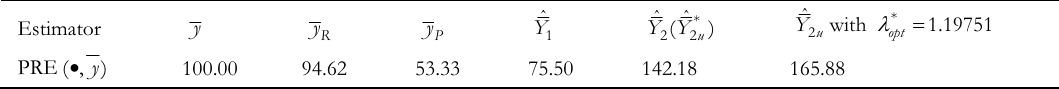
Percent relative efficiencies of different estimators of Y with respect to y